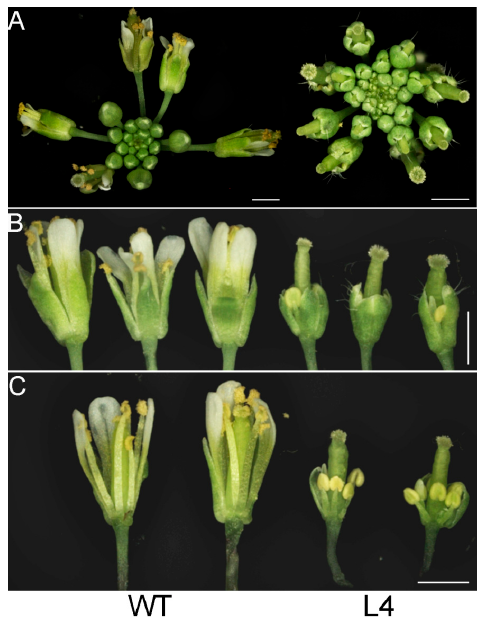
Figure 5. Ectopic expression of JcTPPJ in Arabidopsis affects floral organ development. Inflorescence ( A ), flowers ( B ), and dissected flowers ( C ) of wild ‐ type (WT) and transgenic Arabidopsis line L4. The bars represent 1.0 mm.